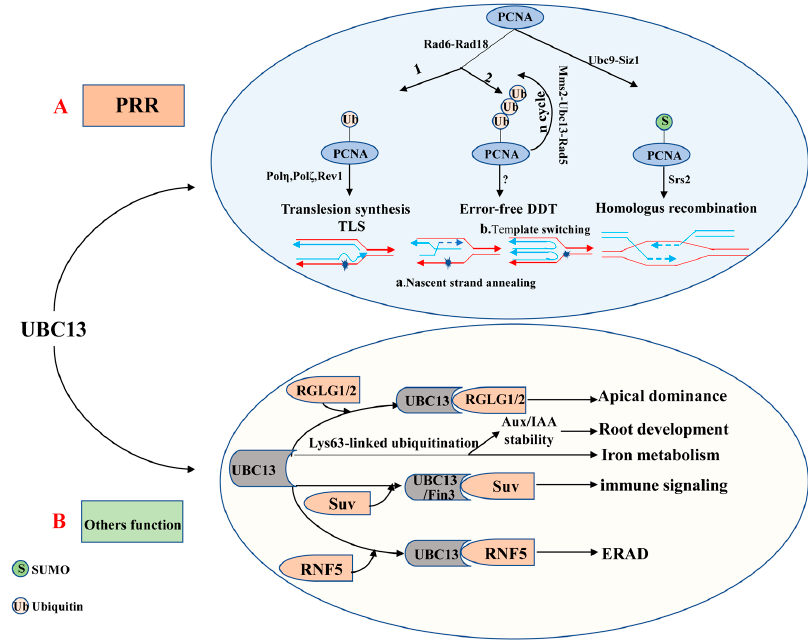
Figure 2. The role of UBC13 in DNA damage responses and UBC13 ′ s other functions. ( A ) UBC13 is involved in post-replication repair (PRR). ( B ) UBC13 participates in different biological processes by mediating Lys63-linked ubiquitination. Abbreviations: Aux/IAA, Auxin/indole-3-acetic acid; DDT, DNA damage tolerance; ERAD, ER-associated degradation; Mms2, A Ubc E2 variant; PRR, Postreplication repair; PCNA, Proliferating cell nuclear antigen; RGLG1/2, An E3 ligase; RNF5, RING finger protein 5; Rad5, An E3 enzyme; Rad6, An E2 enzyme; Rad18, An E3 enzyme; Suv, Fni3 (Fen-interacting protein, Fen is the host protein kinase) cofactor S. lycoperiscum Uev; Siz1, An E3 ligase; Srs2, A helicase; TLS, Translesion DNA synthesis; Ubc9, An E2 enzyme.